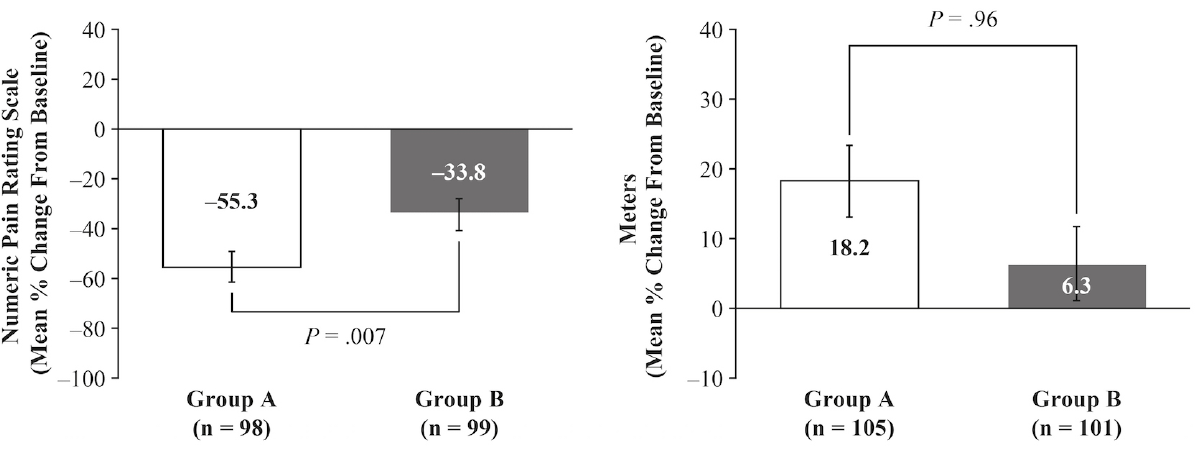
Figure 4. Six-minute walk test. Mean percentage change from baseline to day 90 in pain during the test and distance walked. Data are presented as least squares means and standard error. P values obtained from rank analysis of covariance.